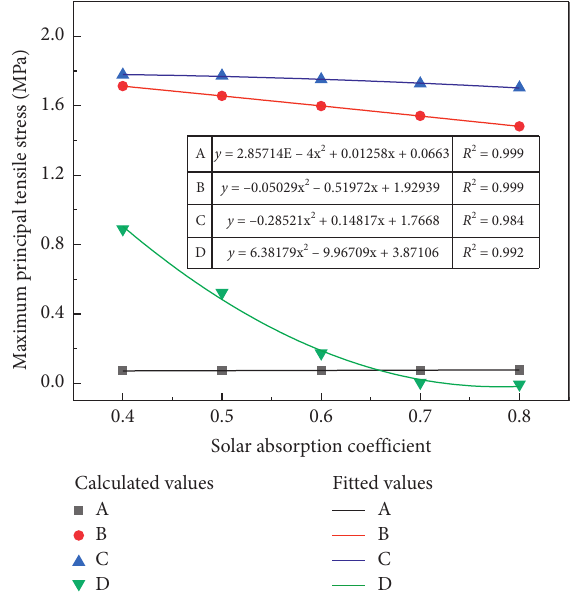
Figure 13: The calculated and fitted maximum principal tensile stress at each point with the different solar absorption